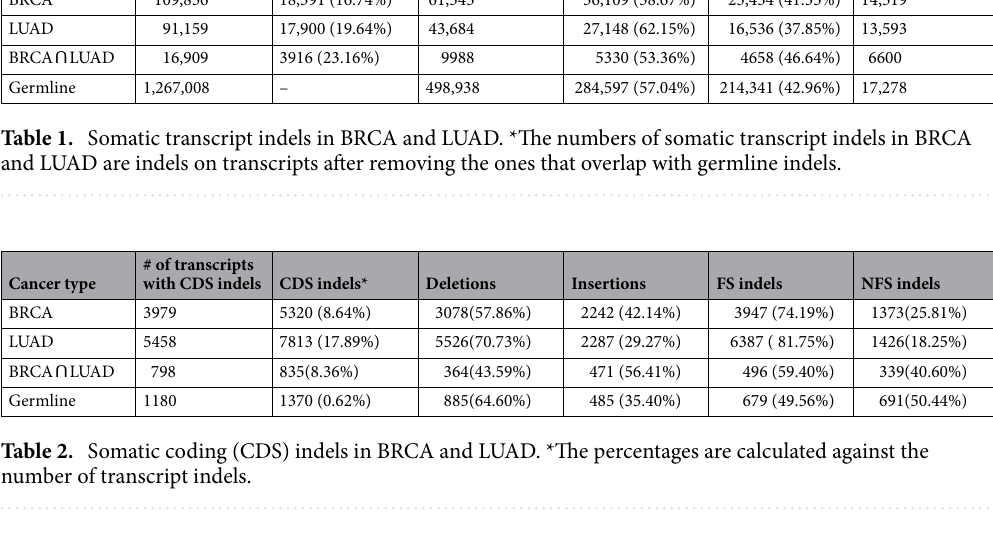
Table 2. Somatic coding (CDS) indels in BRCA and LUAD. *The percentages are calculated against the number of transcript indels.